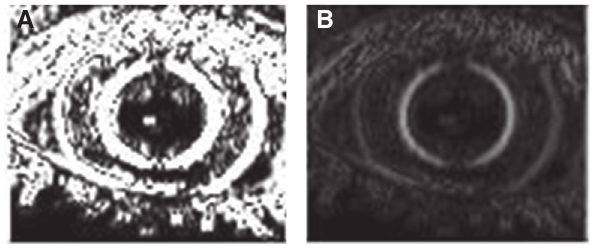
Figure 6. Image Brightness Enhancement. (A) Image gradient before gamma correction. (B) Image gradient after gamma correction.